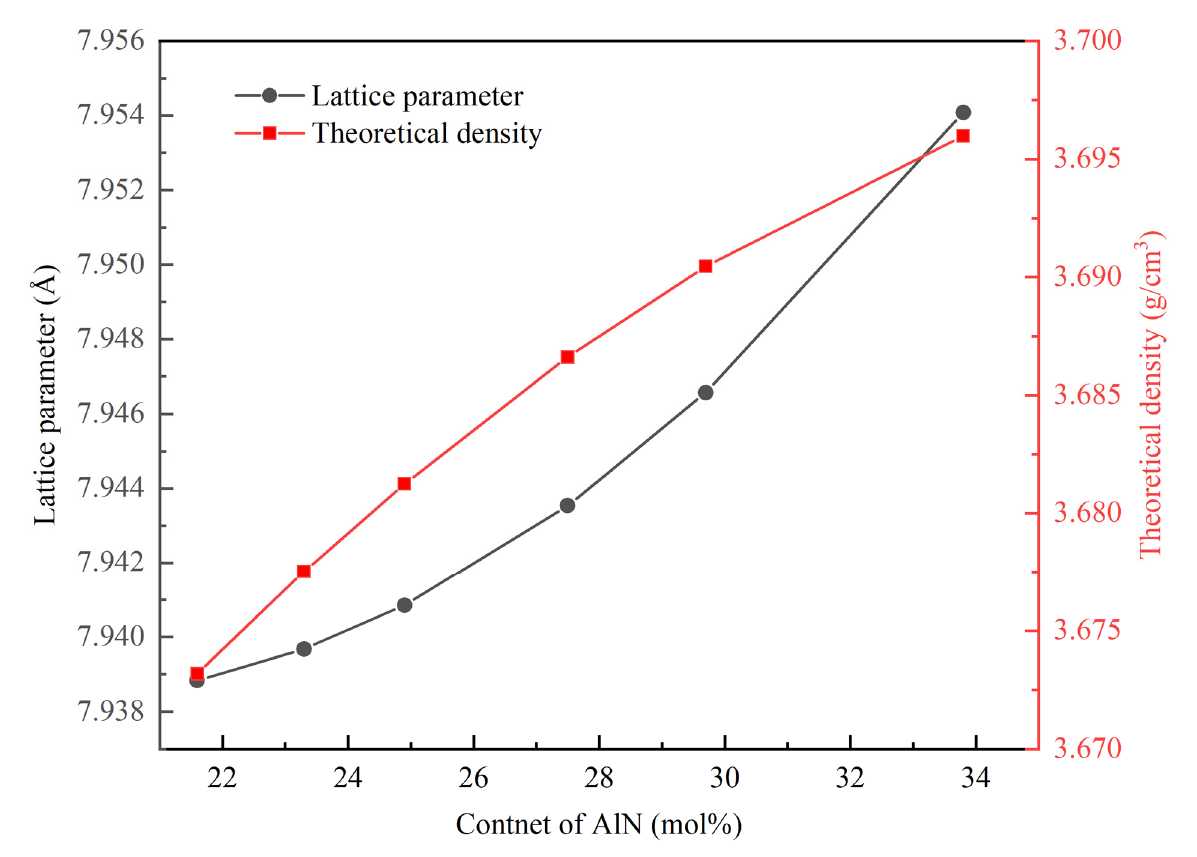
Figure 10. Effect of AlN content on lattice parameter and theoretical density of AlON [16,27,29]. Table 2. Lattice parameters, AlN content and theoretical density of AlON synthesized at 1670 °C for various time.